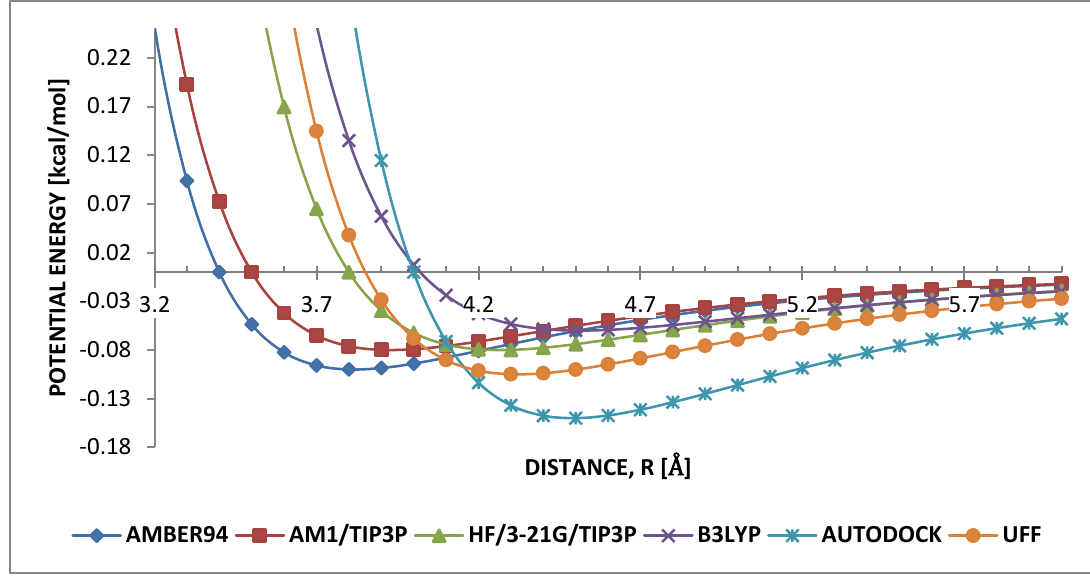
Figure 5. Comparison of Lennard-Jones (LJ) parameters for carbon–carbon.